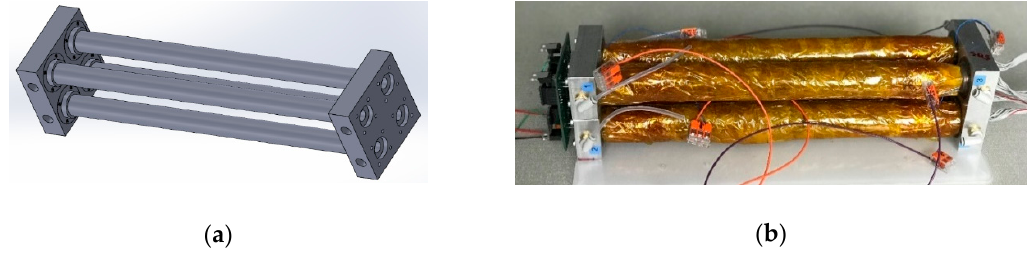
Figure 3. Optical electronic nose 2 × 2 gas sensor chamber formation: ( a ) 3D model; and ( b ) manufactured prototype.